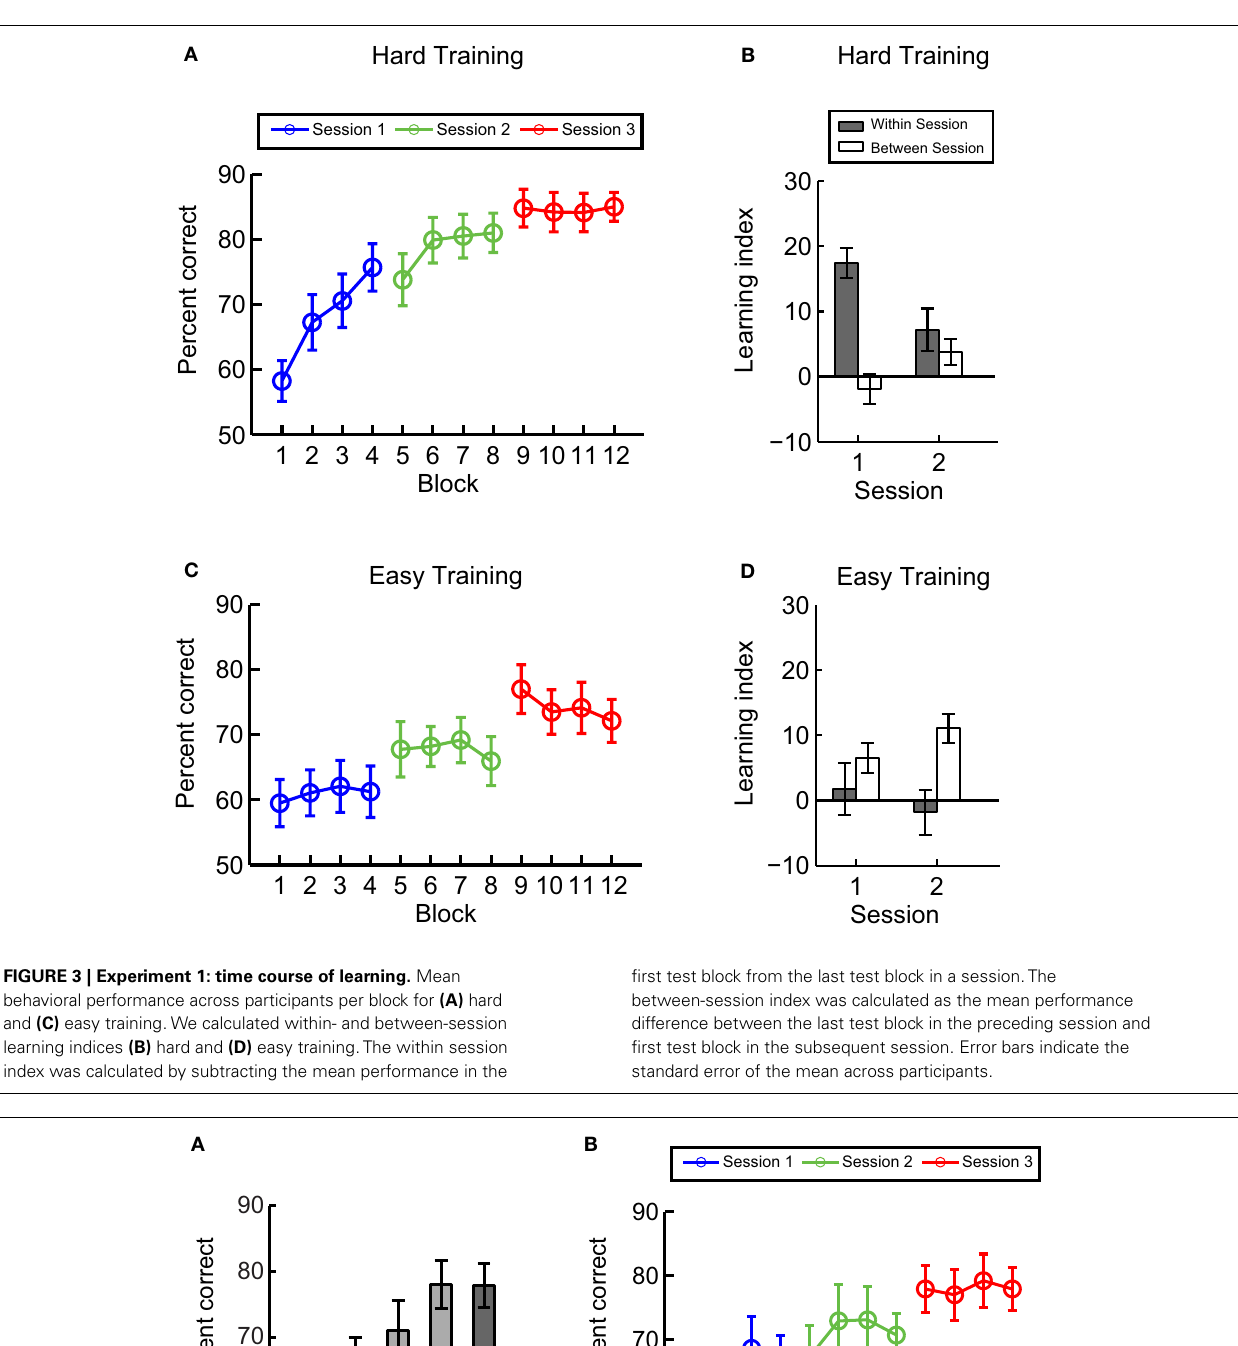
FIGURE 3 | Experiment 1: time course of learning. Mean behavioral performance across participants per block for (A) hard and (C) easy training.We calculated within- and between-session learning indices (B) hard and (D) easy training.The within session index was calculated by subtracting the mean performance in the